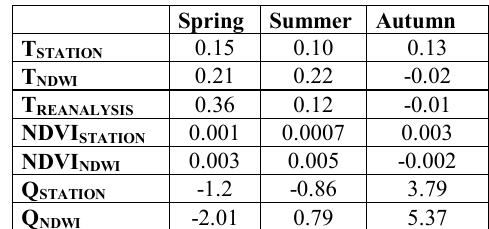
Table 1. The coefficients of the linear trends of surface air temperature (T), NDVI and precipitation sums (Q) for growing seasons allocated using meteorological station data (T STATION ,